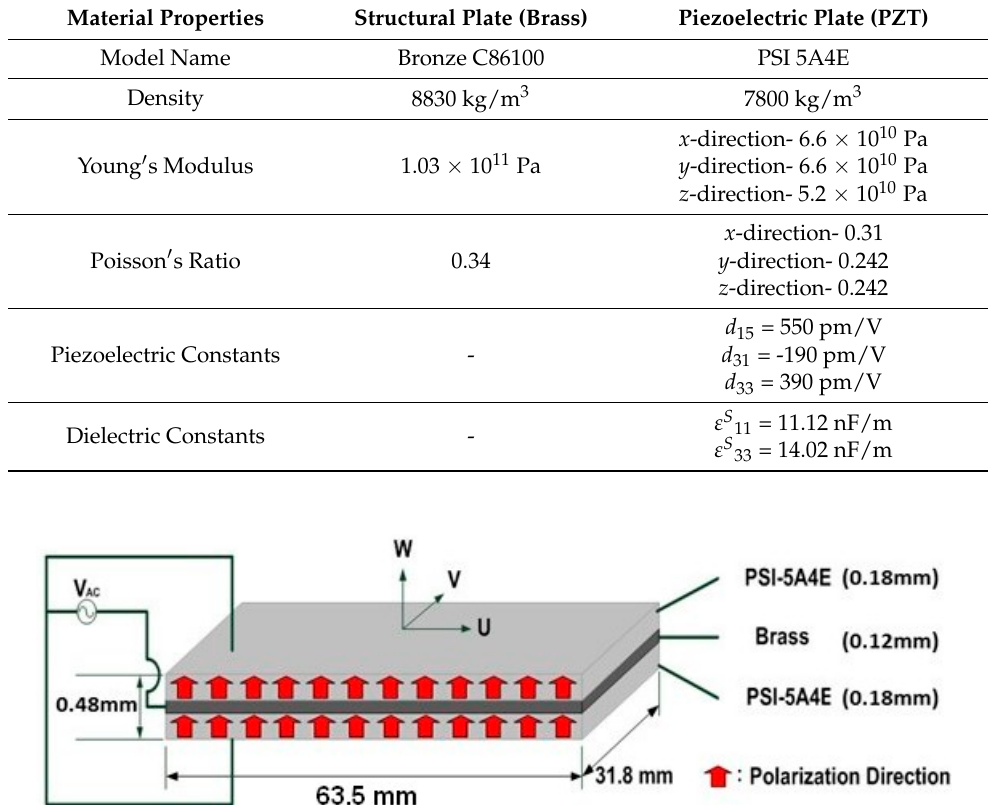
Table 1. Material properties of piezoelectric bimorph.